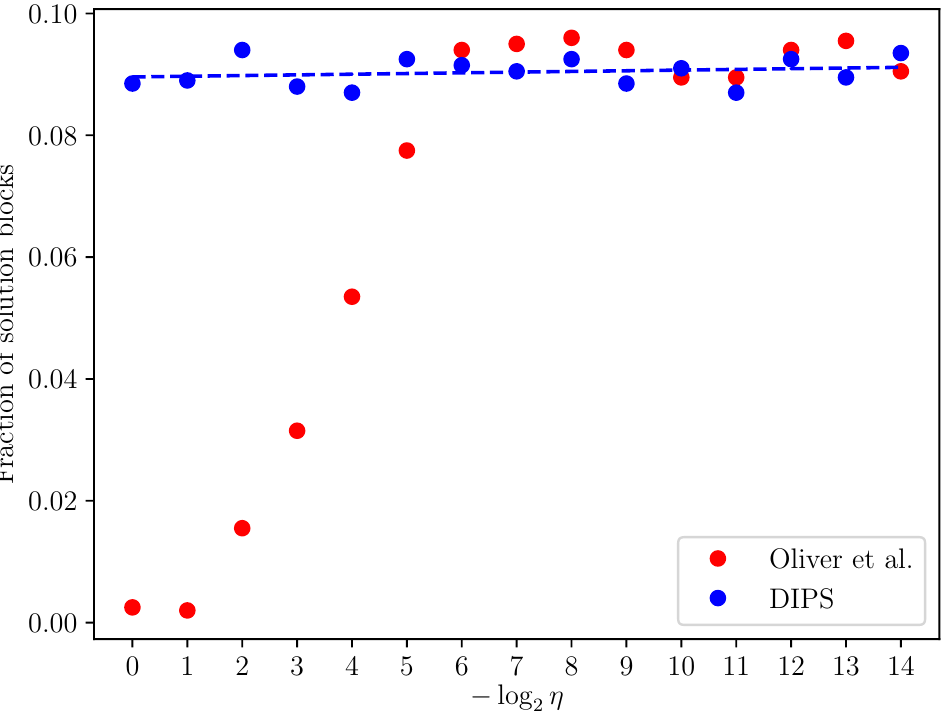
Fig. 4. Fraction of blocks mined with a solution after 200 total blocks for the proof-of-work protocol Oliver et al. (red) and DIPS (blue) as a function of η . In Oliver et al. , η is enforced by the network, while in DIPS it is the initial ratio d r / d b . The fraction of blocks with solutions does not depend on the value of η for DIPS. The blue dashed line is the average value of the fraction of blocks with solutions over values of η . For Oliver et al. the fraction of solution blocks converges to the DIPS value (dashed blue line) in the limit where η represents an average of 10 independent blockchain instances of height 200. Parameters are chosen as in Figure